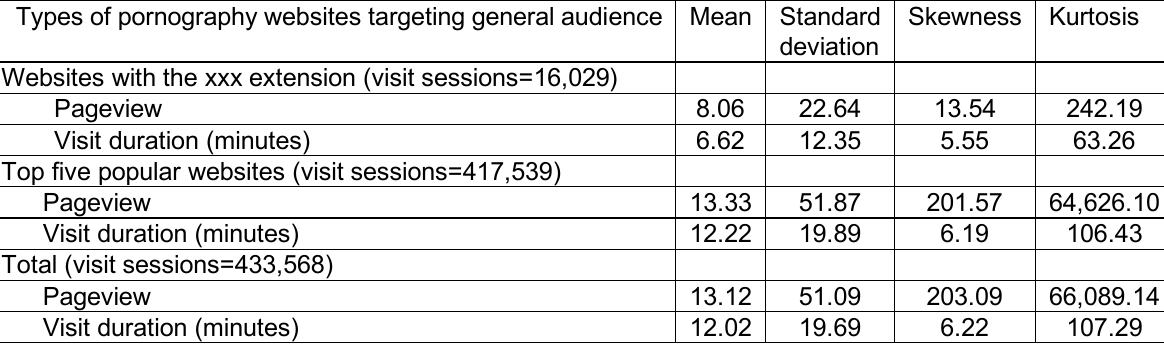
Table 2: Descriptive statistics of pageview and visit duration classified by the two groups of pornography websites satisfying general